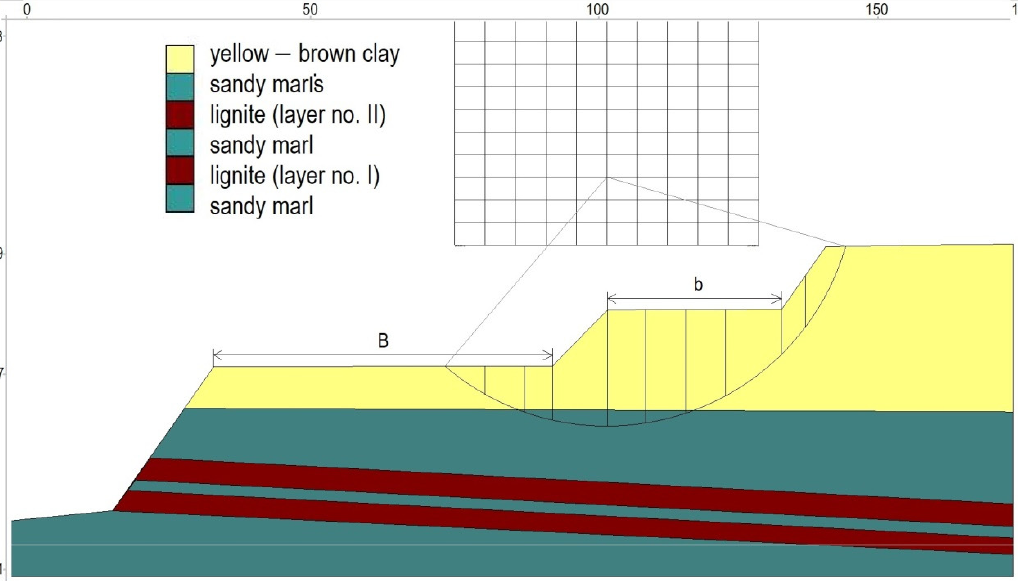
Figure 13. Section P1—Stability analysis of the sub-steps system (excavated in yellow-brown clay).